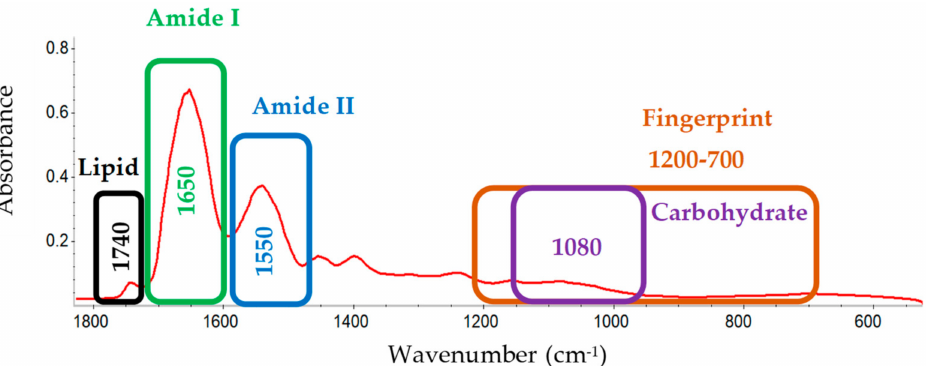
Figure 1. Full pea protein mid-infrared spectrum, with wavenumber identifiers. Mid-IR spectrum highlighting regions discussed: lipid region (1740 cm − 1 ) (black), amide I region (1700–1600 cm − 1 ) (green), amide II region (1580–1510 cm − 1 ) (blue), fingerprint region (1200–700 cm − 1 ) (orange), and carbohydrate region (1080 cm − 1 )